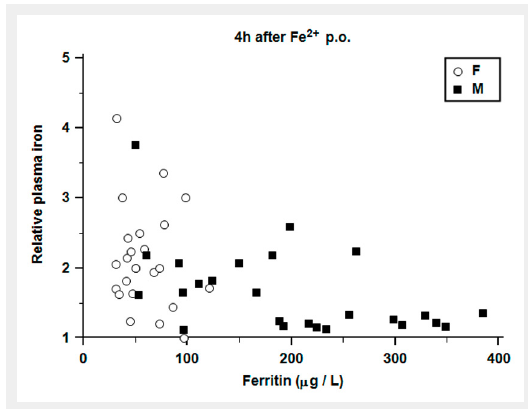
Relative plasma iron concentration. Relative plasma iron concentration during the first test phase. Plasma iron concentration before iron application is defined as reference = 1.0. Females show a greater relative increase of plasma iron. Plasma iron values on day 3 and 5 are comparable to initial values.